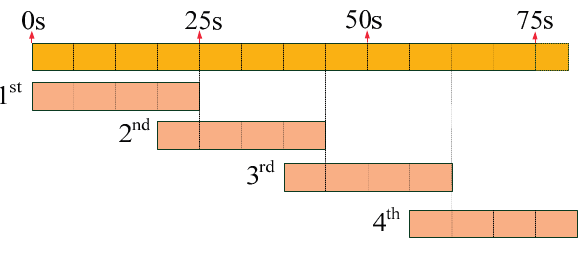
Figure 6. Format of entry data set of input packets for machine